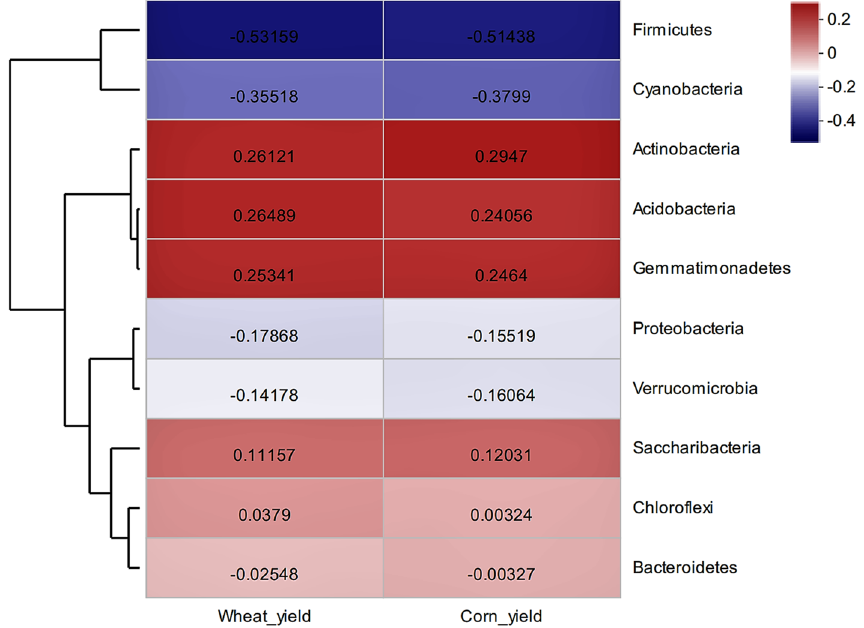
Figure 5. The relationship between crop yield and bacterial community structure in the soft rock:sand compound soil. The image was created with R (pheatmap